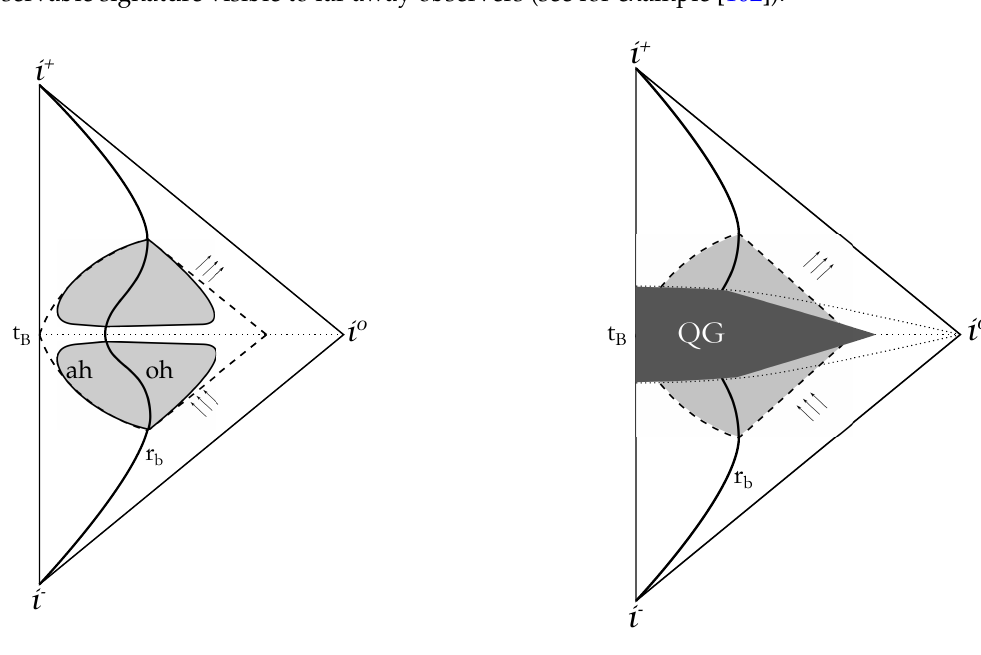
Figure 3. Penrose diagrams for homogeneous collapse with semi-classical corrections. The thick solid line r b represents the boundary of the cloud. The grey areas represent the trapped regions enclosed by apparent horizons. The dashed lines represent the apparent horizon (curved) and the event horizon (straight) in the classical case. Collapse follows the classical behaviour until a certain time before the bounce. All shells bounce at the same co-moving time t B . Left panel : When quantum effects become important the apparent horizon in the interior (ah) starts moving outwards. At the same time the outer horizon (oh) in the exterior moves inward. The two horizons meet and annihilate before t B . At the time of the bounce the cloud is not trapped. After the bounce the solution is described by a time reversal of the collapsing solution, therefore a new trapped region (this time with a white hole horizon) develops for a finite time. In this scenario the bounce affects the whole space time instantaneously. Right panel : The darker grey area represents the region where quantum effects are non negligible. Outside the quantum gravity region (QG) the space-time is given by a classical collapse solution for t < t B and its time reversal for t > t B . Quantum gravity effects reach a portion of the space-time outside the horizon. Dotted lines represent lines of constant t (note that due to homogeneity, in the interior, the quantum gravity region occurs at the same t